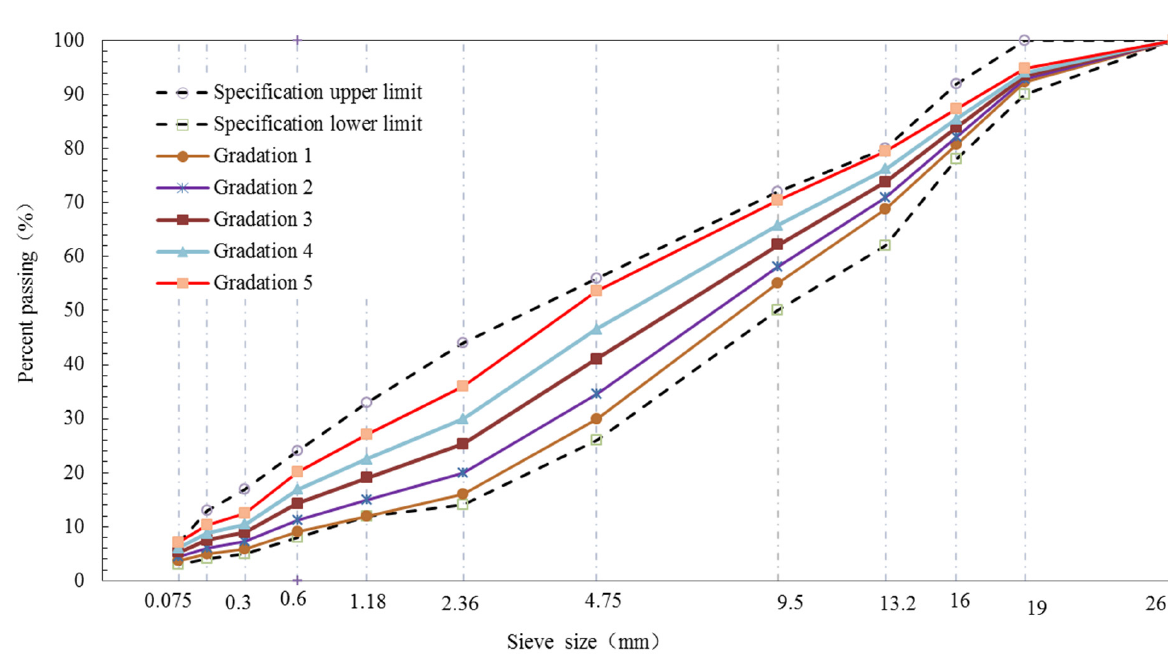
Figure 1. Gradation curves of AC-13.